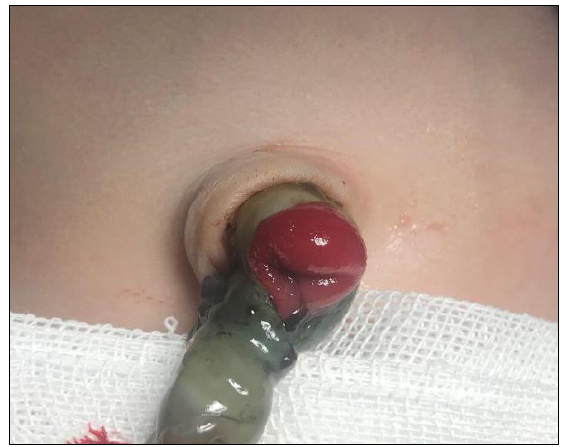
Figure 1: Prolapse of intestine from the umbilicus. The anal opening was normally positioned; however, the baby had not passed any meconium and there were no features of intestinal obstruction. A heart murmur was heard on cardiac auscultation. The rest of the systemic examinations were normal. One hour after birth, a dark-greenish discharge was observed through the end of the protruding mass. Intravenous fluids and empirical antibiotics were started. A grad-